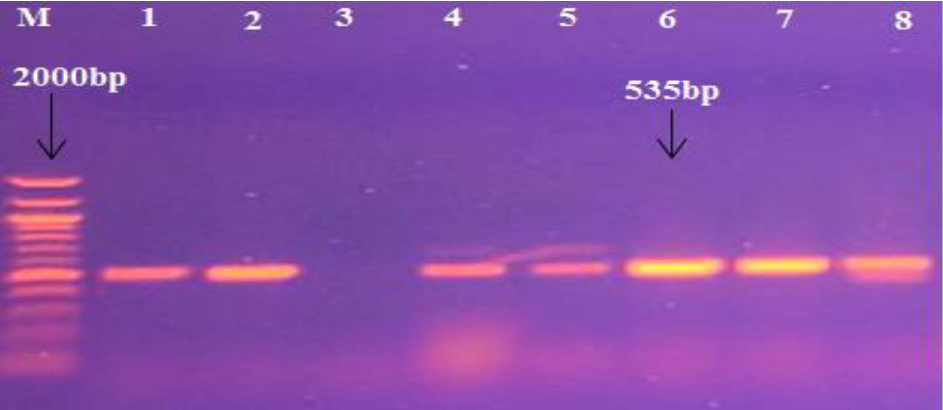
Fig. 3. Agarose gel electrophoresis image that shown the PCR product of etD gene in S. aureus isolates. Where M: Marker (100-2000bp), lane (1-8) some positive PCR amplification at (535bp) PCR product size. Table 5. Prevalence of etD gene in different samples of S. aureus Sample Gene Pus Wound Burn Urine Sputum etD No(%)